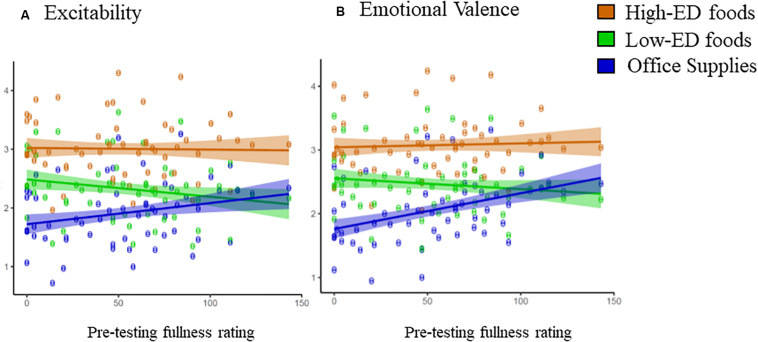
The effect of an interaction between category of image (e.g., high-ED, low-ED, and office images) and fullness score on ratings of image excitability and emotional valence-A. The slopes between excitability and fullness differed by the category of item pictured [p = 0.002; F(290) = 634]. The slope for office supplies was greater than the slope for high-ED and low-ED foods; however, the slope for low-ED foods did not differ from the slope for high-ED food& Ratings of excitability of low-ED foods and office supplies were significantly different at lower levels of fullness, but were not significantly different at higher levels of fullness- B. The slopes between emotional valence and fullness differed by the category of item pictured [p = 0M004; F(2294) = 7.92]. The slope for office supplies was greater than the slope for high-ED foods and office supplies, however, the slope for low-ED foods did not differ from the slope for high-ED foods. Ratings of emotional valence of low-ED foods and office supplies were significantly different at lower levels of fullness, but were not significantly different at higher levels of fullness.